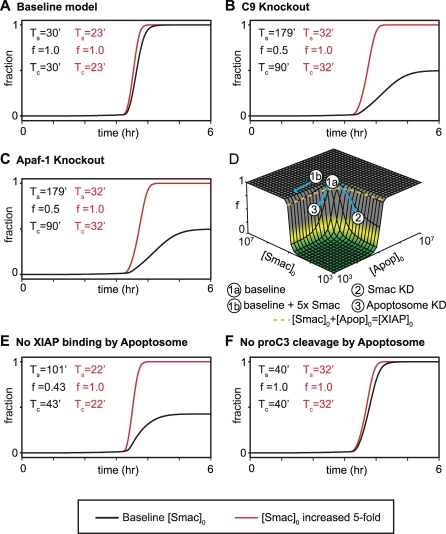
Role of the Apoptosome in Snap-Action C3 Activation(A–C) Simulation of the time course of C3 (EC) substrate cleavage in control cells (A), or cells lacking C9 (B), or Apaf-1 (C). For each condition, simulations were performed using baseline conditions for Smac (black lines), or 5-fold overexpression of Smac (red lines).(D) Simulation of f as a function of initial concentrations of Smac and the apoptosome; for simplicity, the apoptosome components C9 and Apaf-1 were assumed to be present at equal concentrations. Orange dotted line indicates the region where [XIAP]0 = [Smac]0 + [apoptosome]0; numbered circles and cyan arrows indicate the positions of the indicated conditions. Point 1a corresponds to the baseline model, in which either Smac or Apaf-1 knockdown leads to a decrease in f, while point 1b corresponds to the baseline model with 5-fold higher Smac, in which Apaf-1 depletion does not reduce f.(E, F) Simulation of the time course of PARP cleavage in cells in which apoptosome function has been altered so that it cannot process pro-C3 (E) or so that it cannot bind XIAP (F).